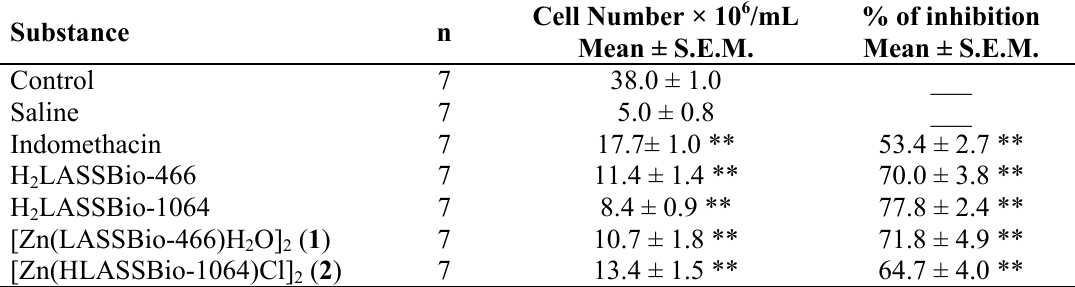
Table 6. Effect of prototypes H and indomethacin (100 µmol·kg − 1 , p.o.) on the zymosan-induced peritonitis in